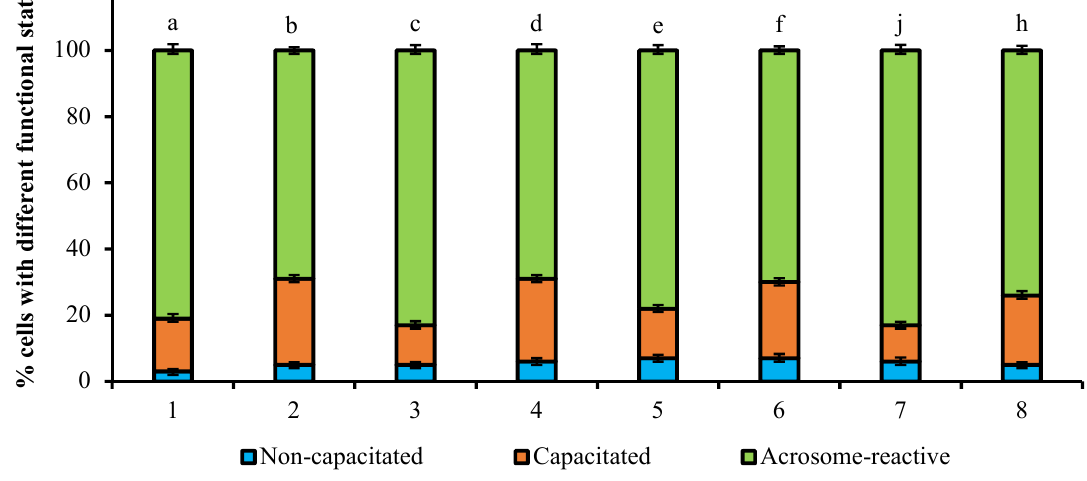
Figure 3. The effect of 1 µ g/mL PRG on capacitation process of bull spermatozoa stimulated by heparin (5 µ g/mL) (total number of counted cells-6400; number of experiments-4). 1—without any reagents (control), 2—with 5 µ g/mL heparin; 3—with 5 µ g/mL heparin and 10 µ M cytochalasin D; 4—with 5 µ g/mL heparin and 10 µ M nocodazole; 5— with 1 mg/mL PRG (control); 6—with 1 mg/mL PRG, 5 µ g/mL heparin; 7—with 1 mg/mL PRG, 5 µ g/mL heparin and 10 µ M cytochalasin D; 8—with 1 mg/mL PRG, 5 µ g/mL heparin and 10 µ M nocodazole. The differences are significant (percent ratio of capacitated and acrosome-reacted cells) a:b; a:d; b:c; c:d; c:b; b:j; d:j; a:f; c:f; f:j at p < 0.001; b:d; d:e; a:h; e:f; f:j; e:h; j:h at p < 0.01 (Student’s t -test).